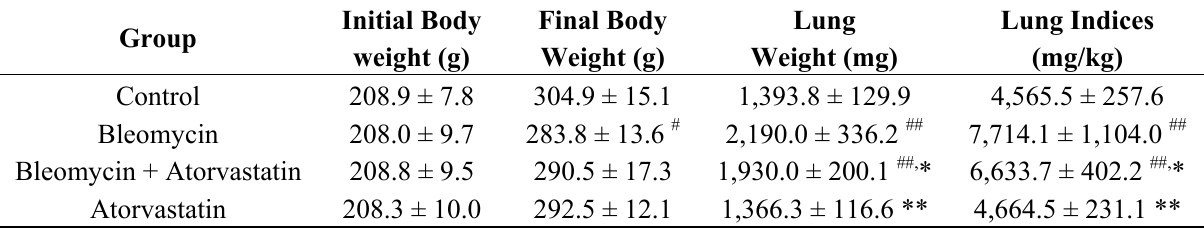
Table 1. Effect of atorvastatin on body weight and lung indices of bleomycin-induced pulmonary fibrosis